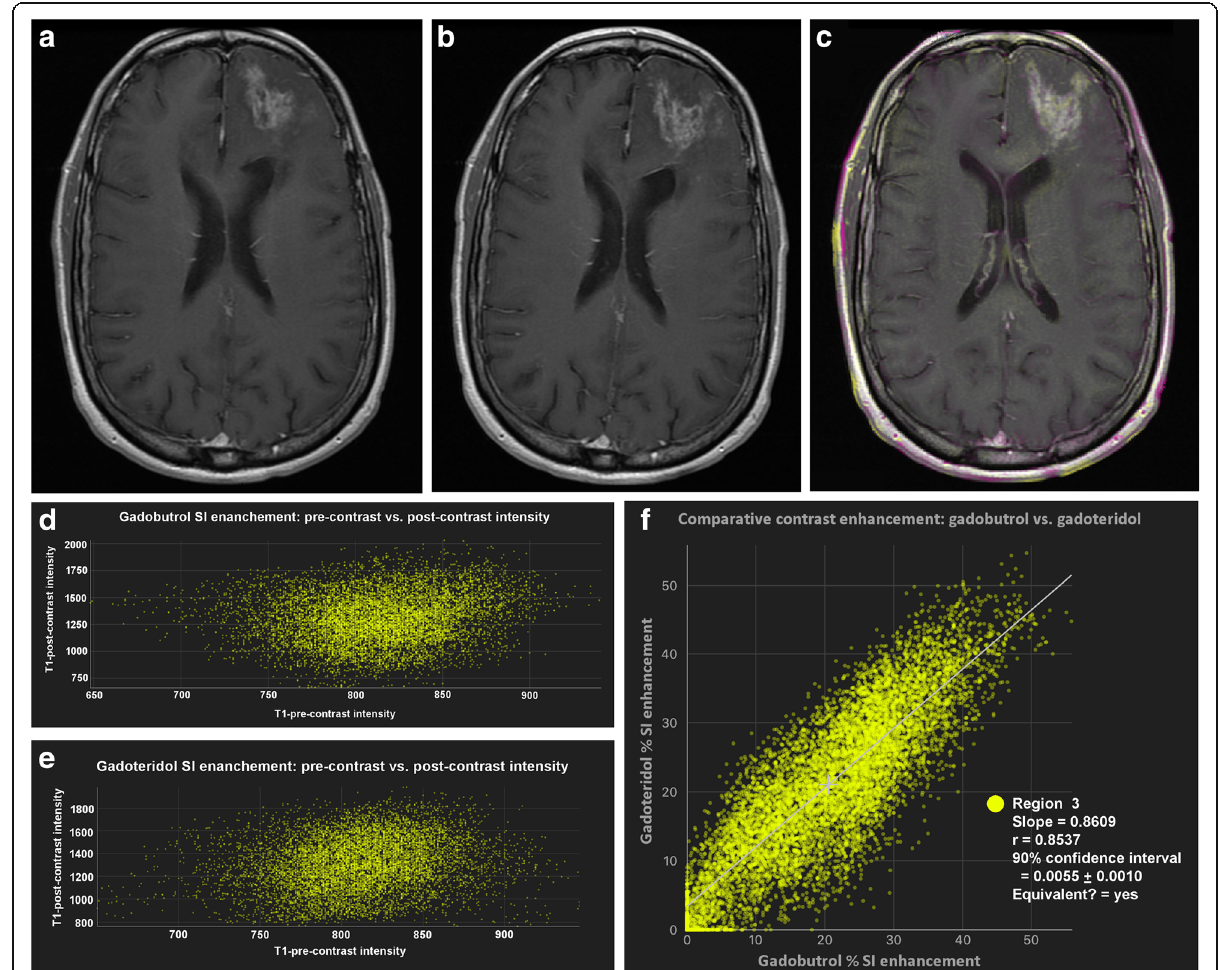
Fig. 10 41-year-old man with glioblastoma in the left frontal lobe. Conventional T1-weighted spin-echo contrast-enhanced images for the first exam with gadobutrol ( a ) and the second exam with gadoteridol ( b ) and the QE change map ( c ) where colour indicates regions differing in enhancement between the two exams. Scatter charts (T1-weighted contrast-enhanced versus unenhanced) of enhancing voxel ROIs reveals the patterns of enhancement for gadobutrol ( d ) and gadoteridol ( e ). The volume of interest was 12.342 cm 3 and 11,140 voxels were measured. The net QE was + 2,102.98 for gadobutrol and + 2,119.53 for gadoteridol. The gadoteridol minus gadobutrol difference (16.55, 0.79%) was not significant and the 90% confidence interval for the mean of the differences fell entirely within the equivalence zone ( f ), indicating equivalence